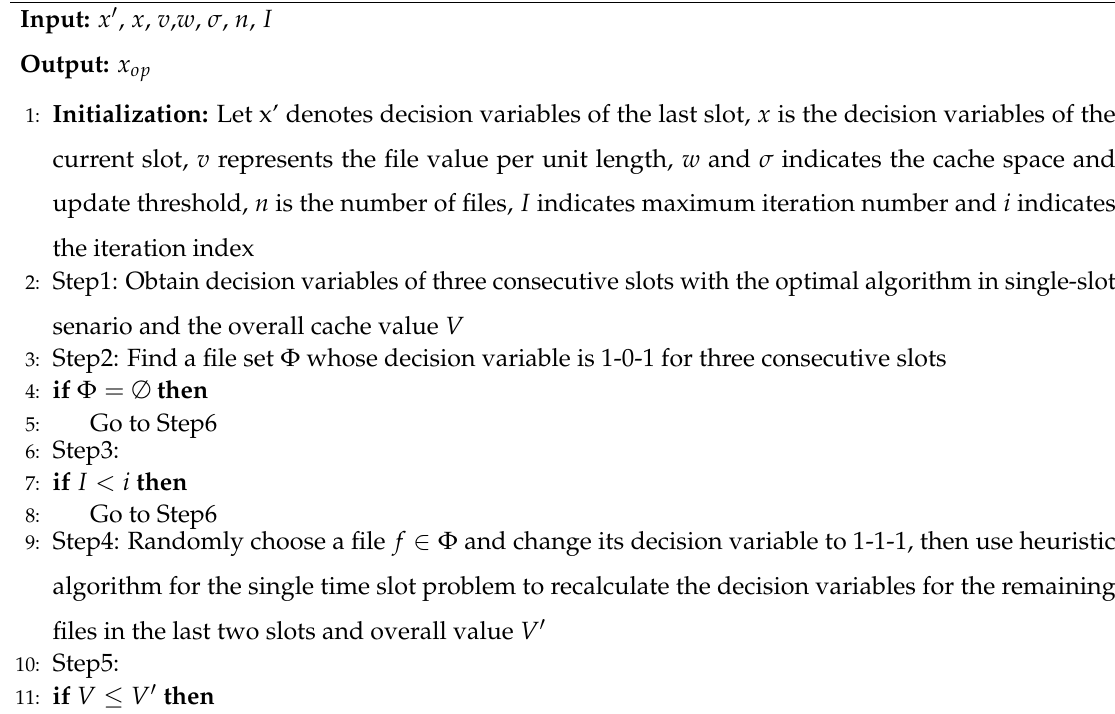
Algorithm 1 Heuristic algorithm for the multi-slot problem